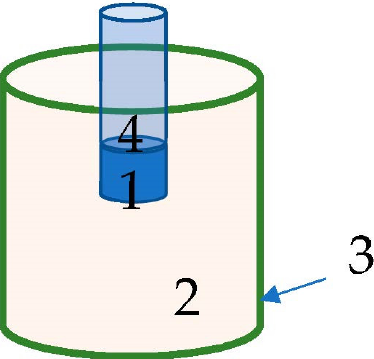
Figure 2. Description of the simulated measurement system that includes a converter where 1. is a 3” × 3” NaI gamma radiation detector; 2. is the PGNA converter; 3. is a cylindrical container for the converter with dimensions of 30 cm diameter and 36 cm height; 4. is the electronic part of the detector (taken as a vacuum in the simulation). A neutron source was placed at a distance of 25 cm from